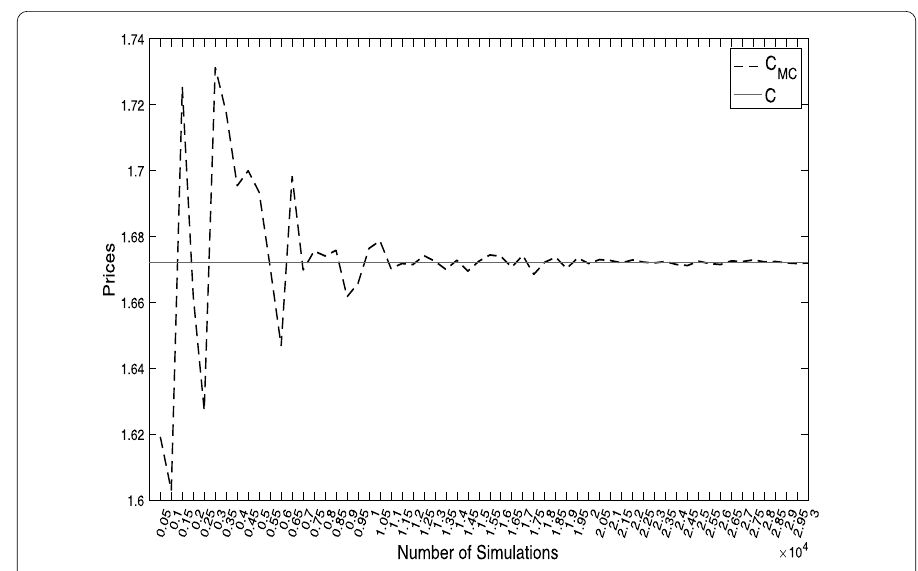
Figure 1 Price convergence of Monte-Carlo simulation for foreign equity option with credit